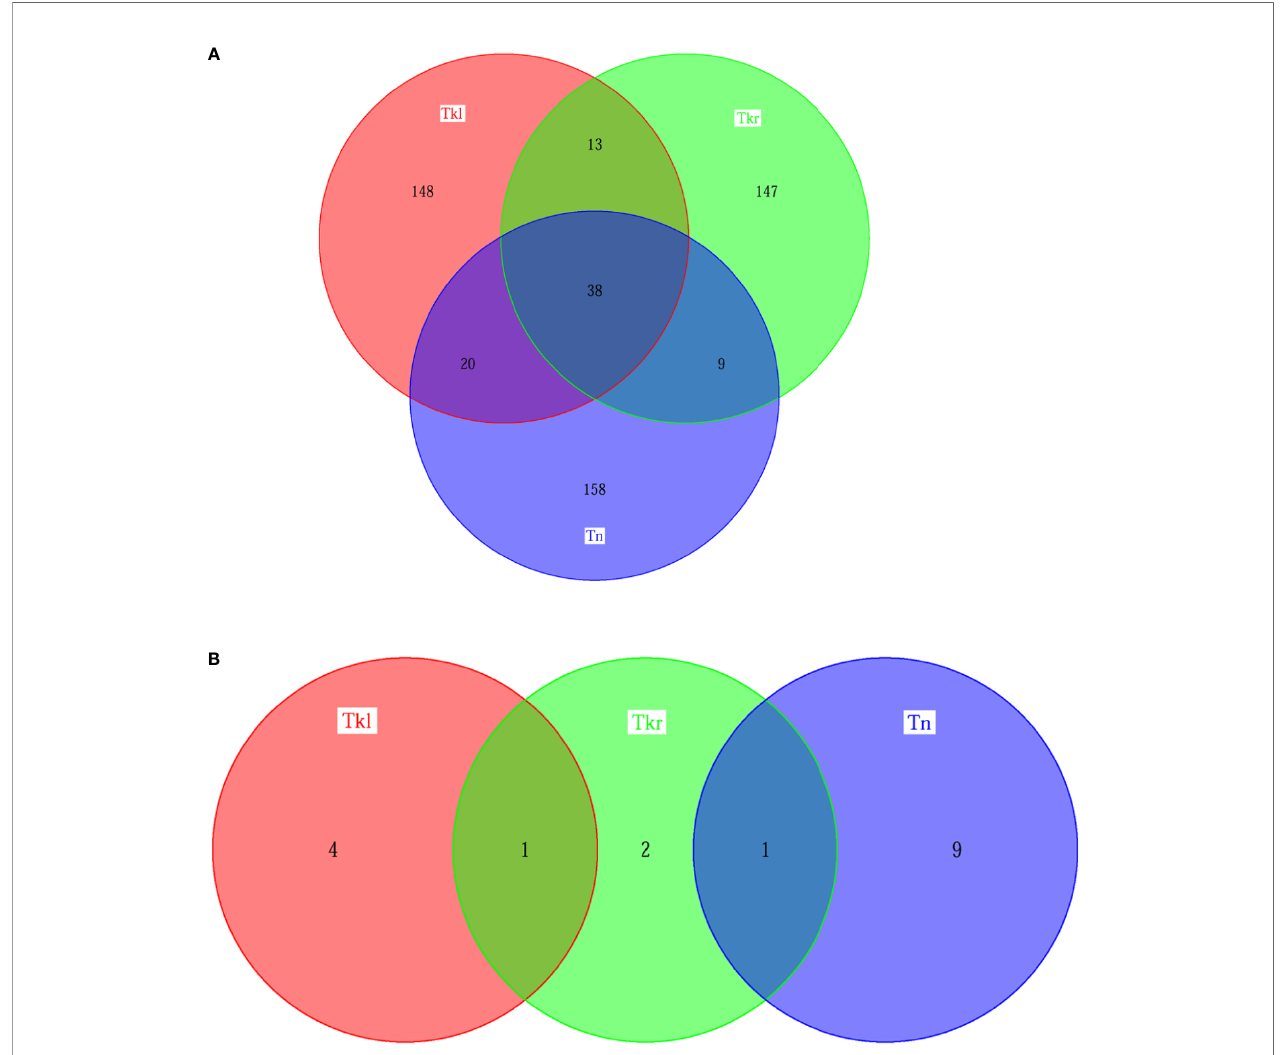
FIGURE 3 | Similarity among different lesions based on somatic mutation analysis. (A) Venn diagram illustrating the distributions of genetic mutation in different lesions [left kidney (Tkl) vs right kidney (Tkr) vs neck (Tn)]. (B) Venn diagram illustrating the distributions of driver genetic mutation in different lesions [left kidney (Tkl) vs right kidney (Tkr) vs neck